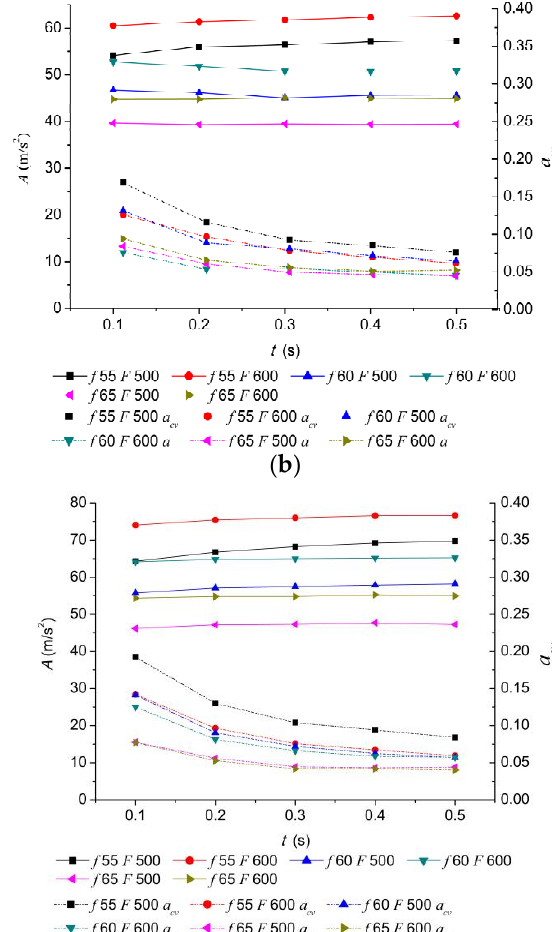
( b ) Figure 7. The curves of A and a cv changing with excitation frequency. ( a ) The curve of A changing with excitation frequency. ( b ) The curve of a cv changing with excitation frequency.